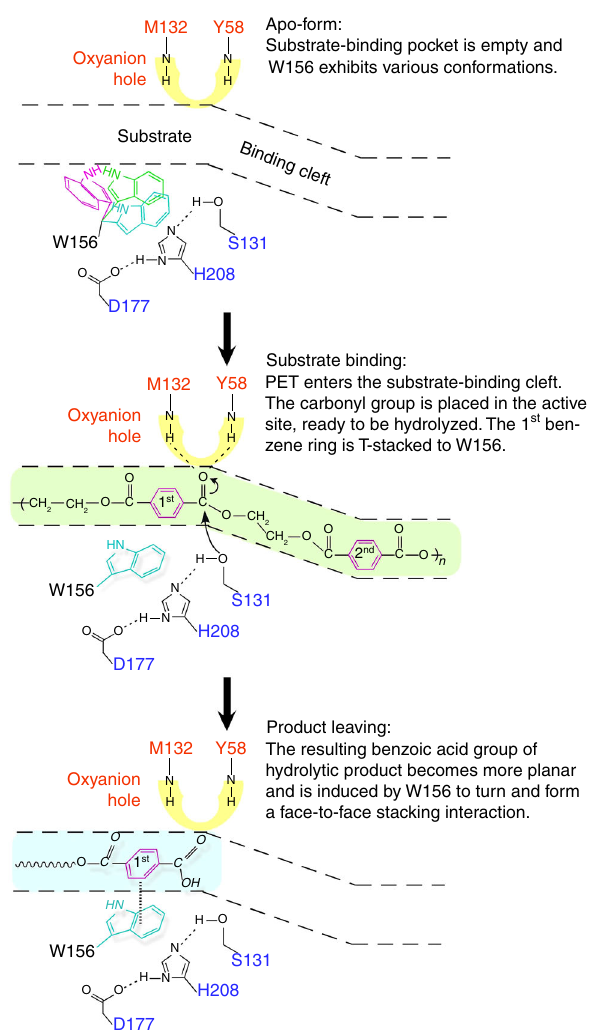
summarized in Supplementary Table 2. All fi gures of the protein and ligand structures were prepared by using the PyMOL program (http://pymol.sourceforge. net/). PET modeling . A two-unit oligomer of PET was superimposed onto the bound HEMT in the complex crystal structure based on the TPA moiety, whereas the ethylene group connecting to the other TPA moiety in the PET took the place of the hydroxyethyl group of HEMT. The position of the second TPA moiety was adjusted manually by torsional rotations of the connecting single bonds while the fi rst TPA remained largely fi xed. After eliminating most major clashes between the non-hydrogen atoms of PET and PETase, the enzyme – substrate complex model was subjected to several cycles of dynamic energy minimization by using PHENIX 21 .